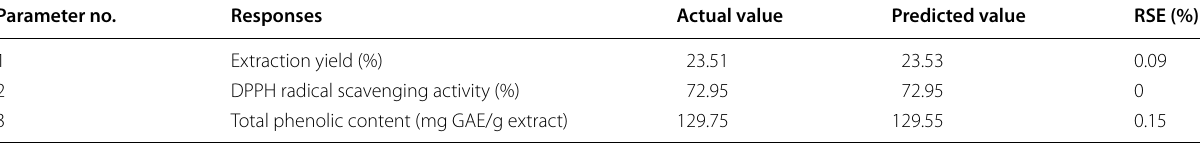
Table 6 Predicted and actual response values for the optimized extraction parameters Parameter